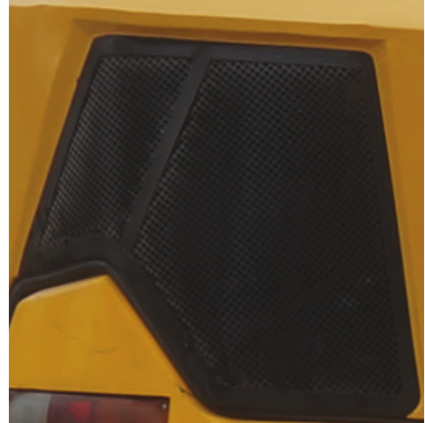
Figure 3: Actual exhaust grids.